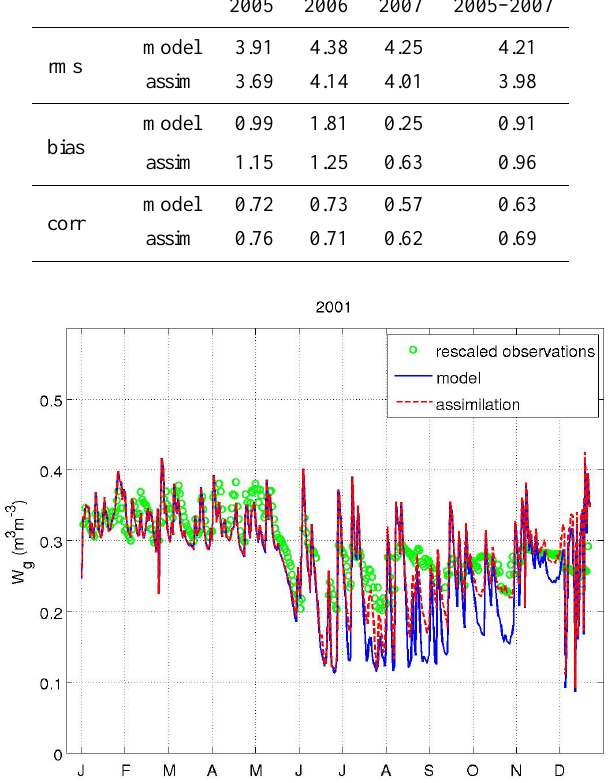
Fig. 13. Time series of observed, modeled and assimilated surface soil moisture (m 3 m − 3 ) for 2001. The observations were rescaled in order to match their statistical distribution to those of